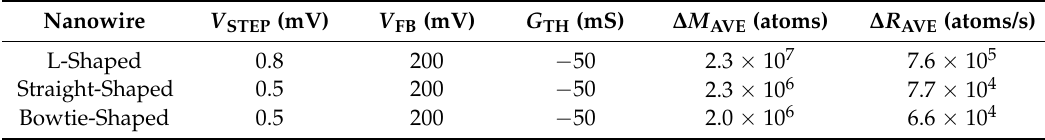
Table 1. FB parameters, average mass transport values, and average rates of mass transport for each Au